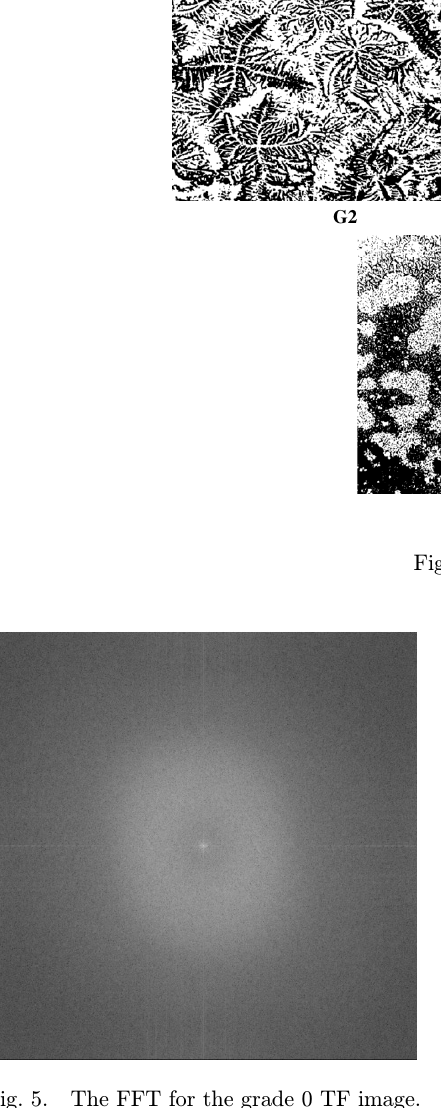
Fig. 5. The FFT for the grade 0 TF